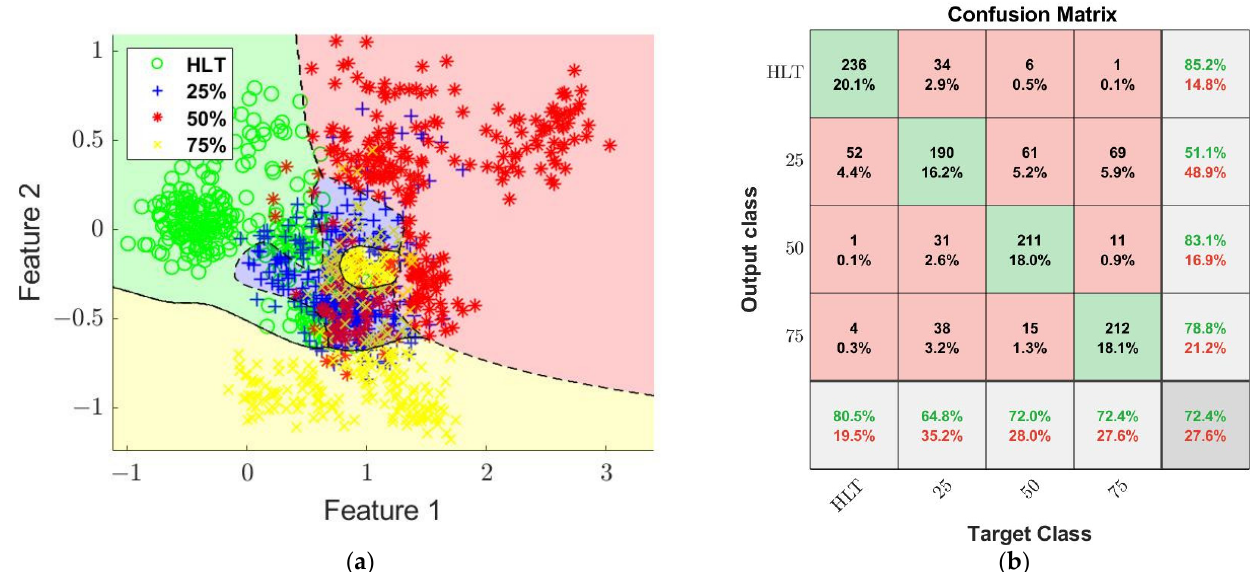
Figure 8. Features optimization through GA for current signal (not data fusion is considered), in ( a ) Two-dimensional projection of clusters (fault conditions) through LDA with limit bounds, and ( b ) Confusion matrix that validates the ANN classification of faults.